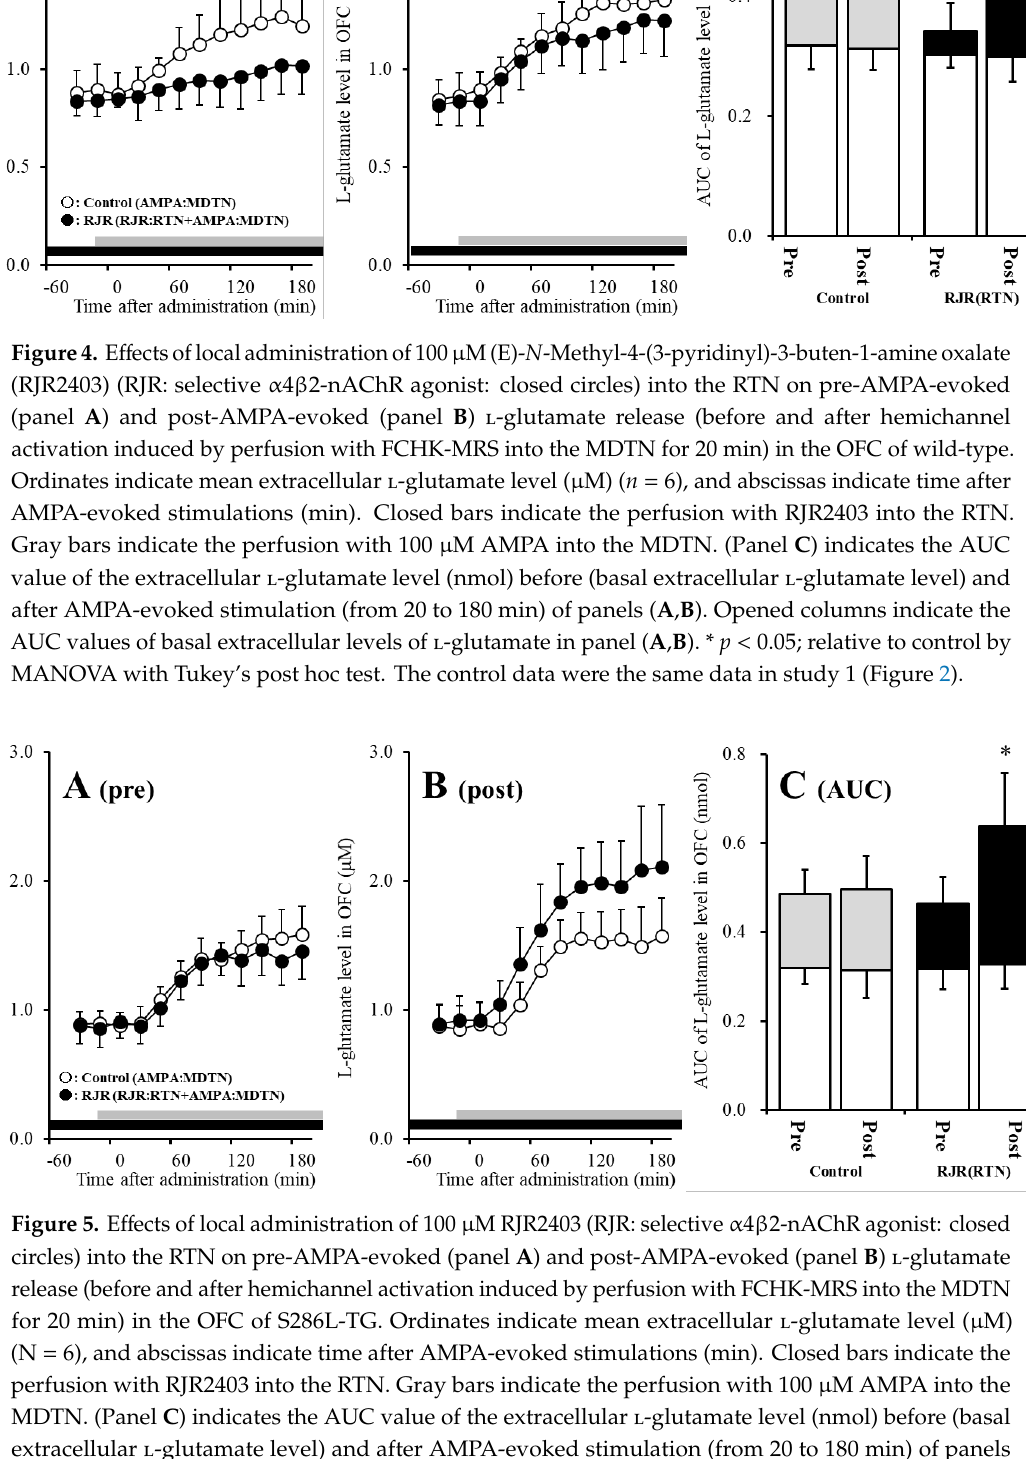
Figure 5. E ff ects of local administration of 100 µ M RJR2403 (RJR: selective α 4 β 2-nAChR agonist: closed circles) into the RTN on pre-AMPA-evoked (panel A ) and post-AMPA-evoked (panel B ) l -glutamate release (before and after hemichannel activation induced by perfusion with FCHK-MRS into the MDTN for 20 min) in the OFC of S286L-TG. Ordinates indicate mean extracellular l -glutamate level ( µ M) (N = 6), and abscissas indicate time after AMPA-evoked stimulations (min). Closed bars indicate the perfusion with RJR2403 into the RTN. Gray bars indicate the perfusion with 100 µ M AMPA into the MDTN. (Panel C ) indicates the AUC value of the extracellular l -glutamate level (nmol) before (basal extracellular l -glutamate level) and after AMPA-evoked stimulation (from 20 to 180 min) of panels ( A , B ). Opened columns indicate the AUC values of basal extracellular levels of l -glutamate in panel ( A , B ). * p < 0.05; relative to control by MANOVA with Tukey’s post hoc test. The control data were the same data in Figure 3.